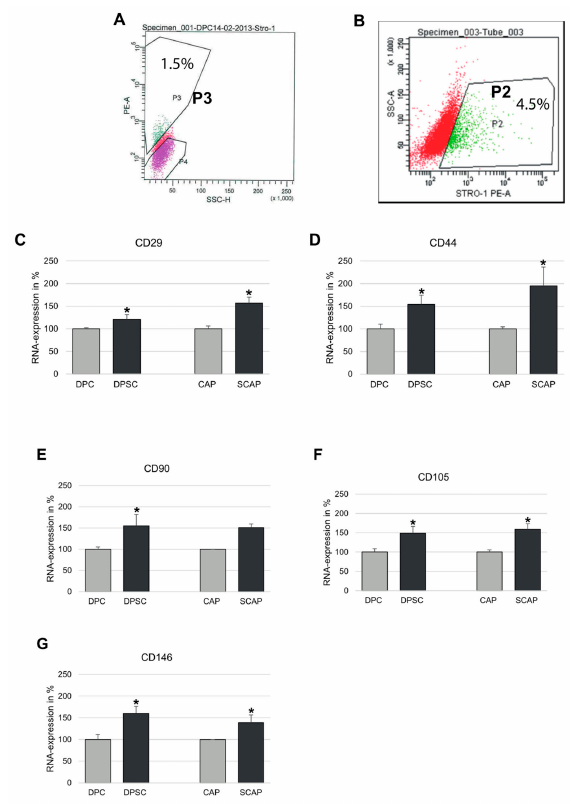
Figure 1. FACS-mediated sorting and expression of mesenchymal stem cell markers in DPC and CAP. ( A ) DPC and ( B ) CAP cell populations were sorted according to the expression of stem cell marker STRO- 1; STRO-1-positive subpopulations were named as DPSC and SCAP, respectively; representative gates P3 (1.5% of DPSC) and P2 (4.5% of SCAP) demonstrate PE (phycoerythrine) STRO-1-positive cells. ( C – G ) Expression of mesenchymal stem cell markers in STRO-1-negative (DPC and CAP) and STRO-1-pos- itive (DPSC and SCAP) DPC and CAP. All cell populations were tested for the expression of ( A ) CD29, ( B ) CD44, ( C ) CD90, ( D ) CD105, and ( E ) CD146; means ± SD of three independent experiments; * p < 0.05 indicates statistical significance (vs. STRO-1-negative cells).